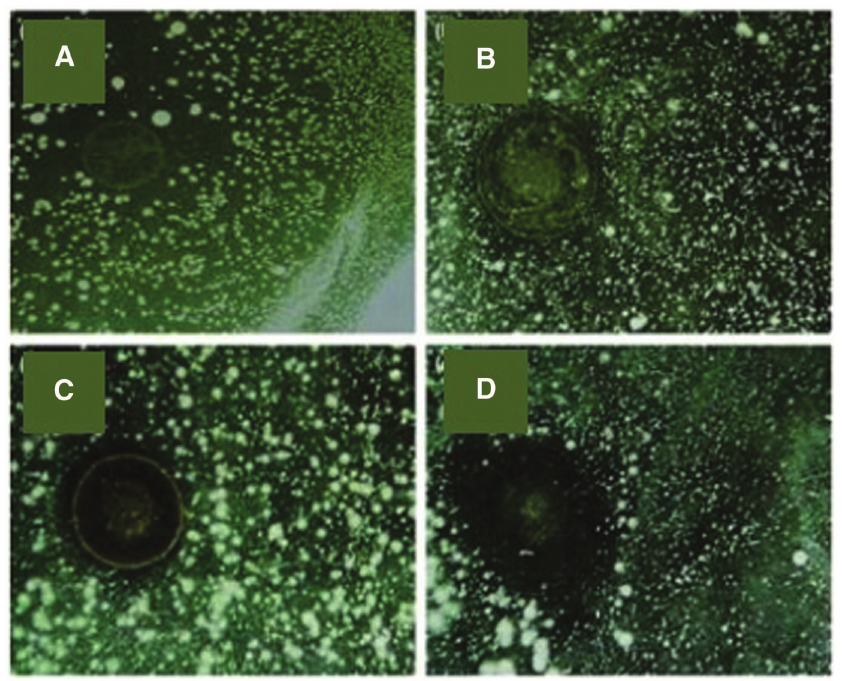
Figure 21: The antibacterial results of the hydrogel/silver nanoparticles; (A–D) dead bacteria zone increases by silver nanoparticle size decrease. Reprinted from Ref. [50], Copyright (2006), with permission from Elsevier.